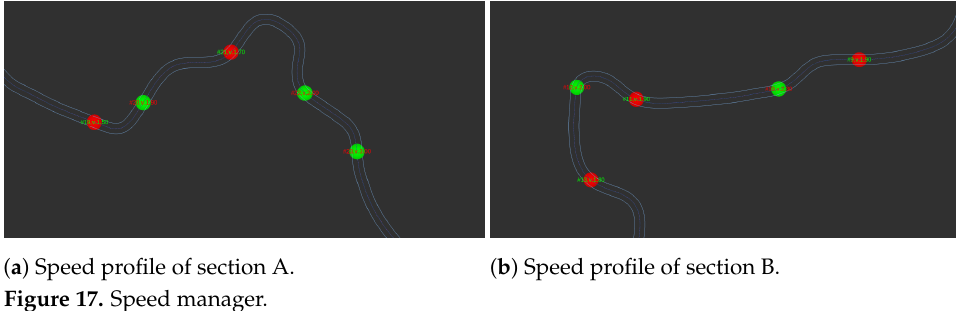
Figure 17. Speed